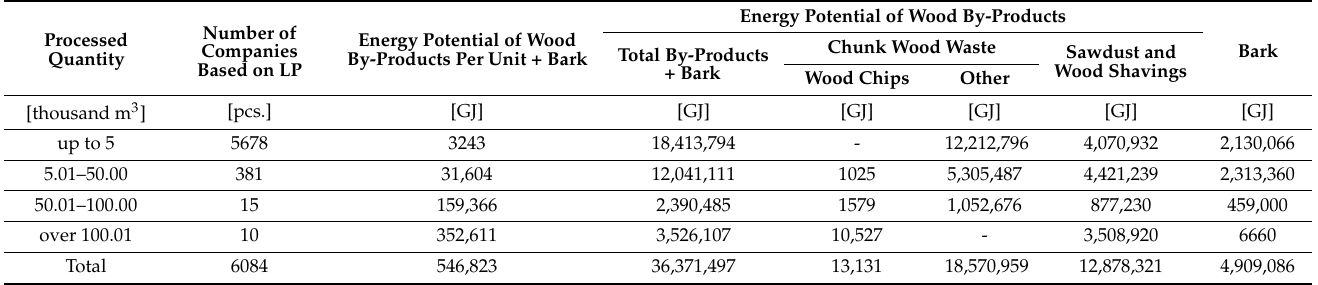
Table 9. Energy potential of wood by-products generated during wood processing by sawmills.